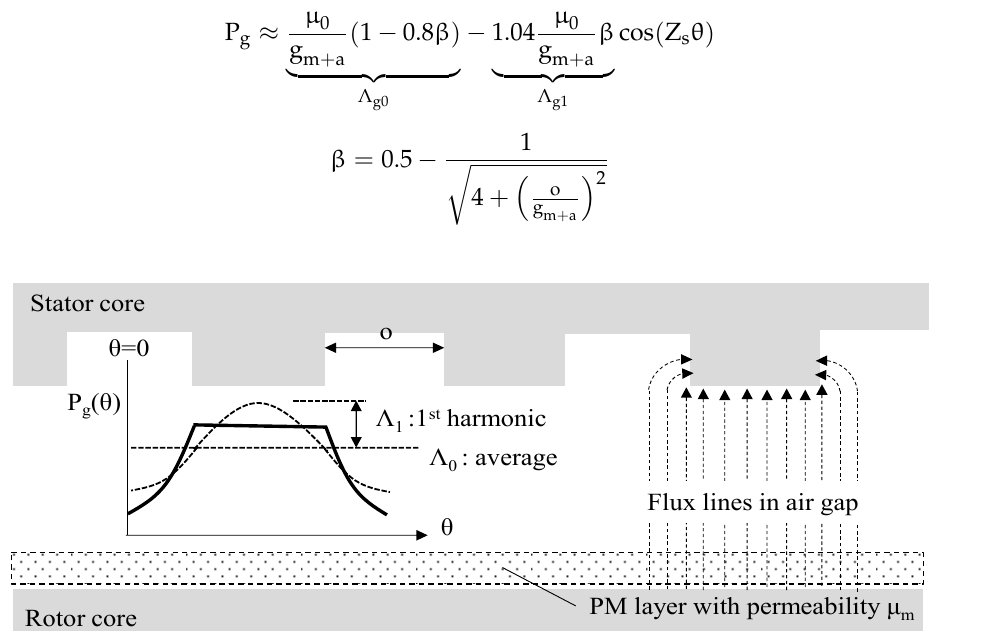
Figure 2. Specific permeance function of air gap.